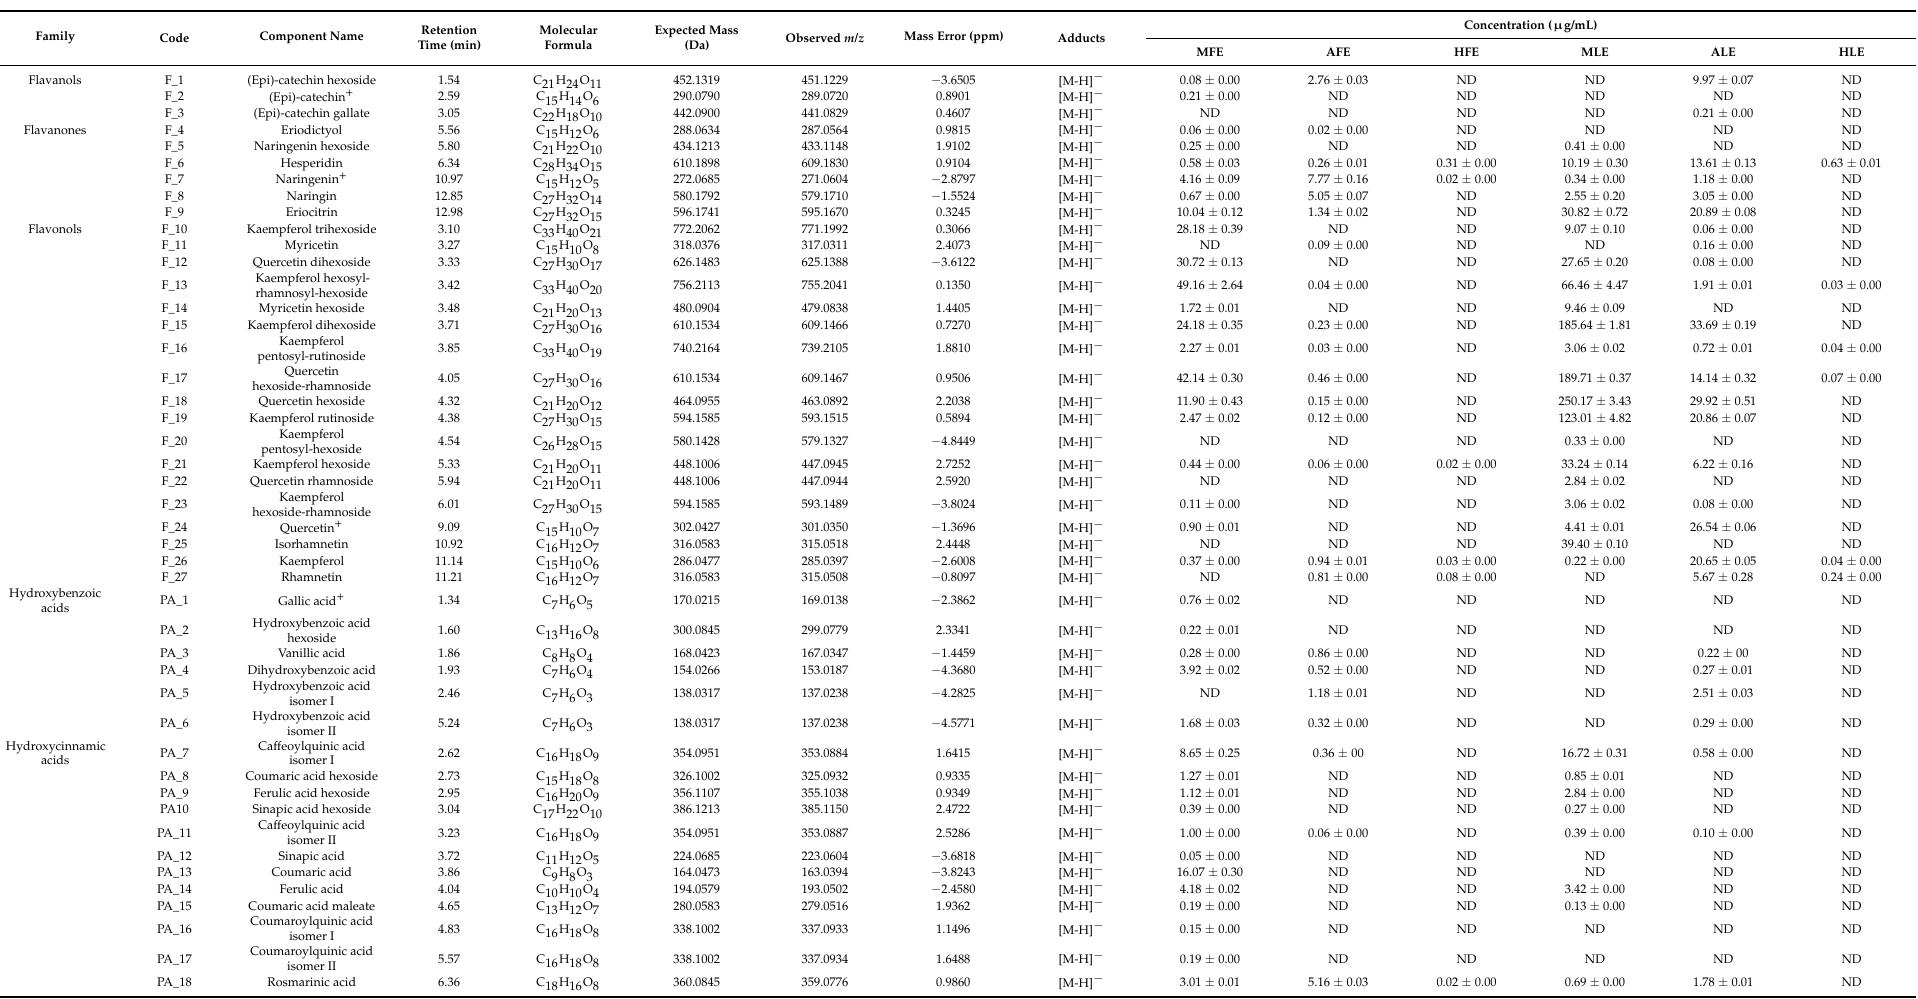
Note: Data are shown as mean ± standard deviation of three replicates. + Confirmed with commercial